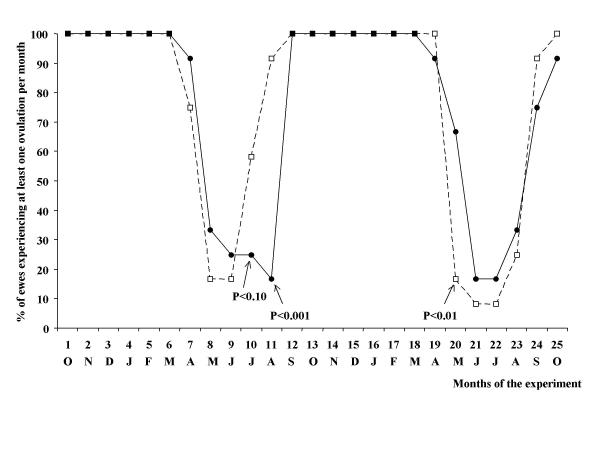
Ovulatory activity in Black-Belly ewes maintained under two different photoperiodic conditions. Two groups of Black-Belly ewes were maintained in light-proof rooms and subjected to either simulated temperate photoperiodic conditions (TE solid line closed circles, 12 ewes, 8 to 16 hours of light per day from winter to summer solstice) or simulated tropical photoperiodic conditions (TR dashed line open squares, 12 ewes, 11 to 13 hours of light per day from winter to summer solstice) for 25 months. Ovulatory activity was assessed by once-weekly determinations of plasma progesterone by radioimmunoassay. Results are expressed as the percentage of ewes experiencing at least one ovulation per month. Significant differences between groups are indicated.